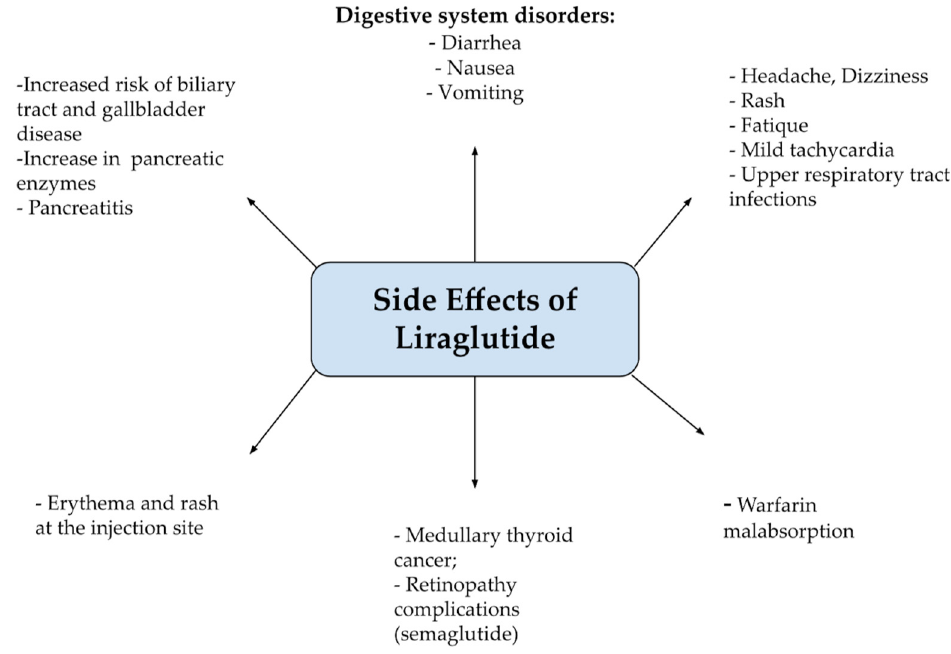
Figure 2. Most common adverse events of liraglutide